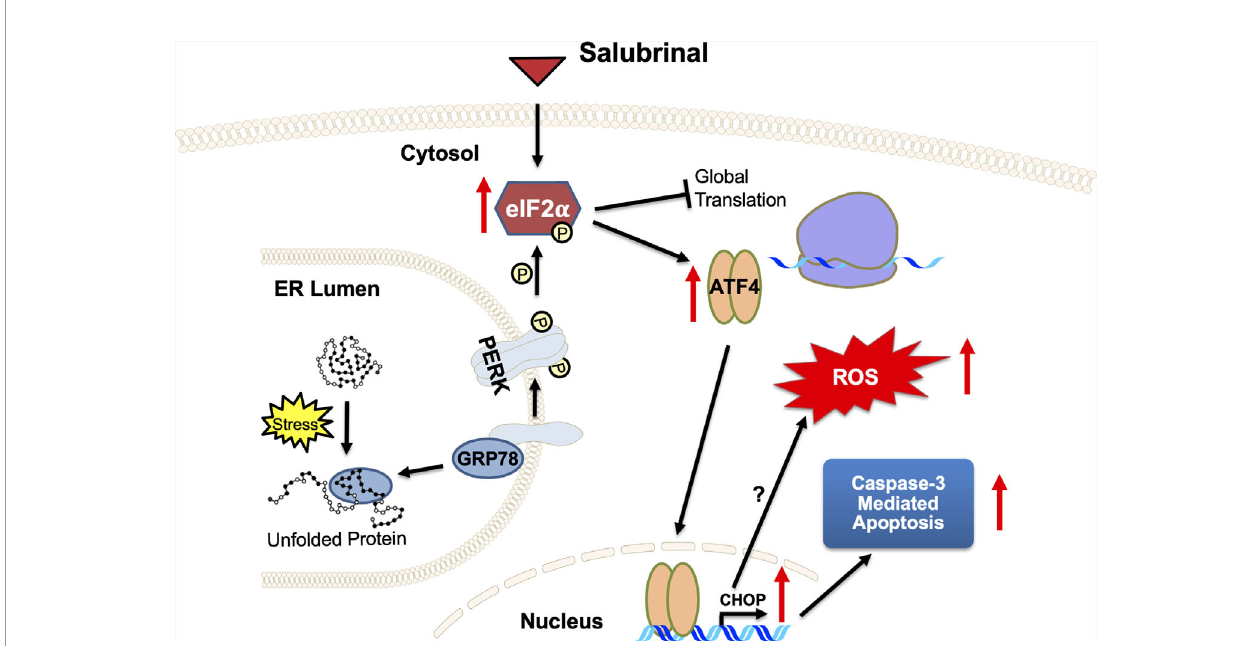
FIGURE 8 | A proposed mechanism of action of ER stress ‐ prolonging agent Salubrinal on IBC cells. Cellular stress causes unfolded proteins to accumulate in the ER lumen. Chaperone dissociation leads to the activation of the PERK arm of the UPR. PERK is a transmembrane protein that serves as an ER stress sensor and activator of the UPR. PERK phosphorylates eIF2 a , thereby inhibiting global translation and selectively promoting ATF4 and CHOP translation, stress-inducible transcription factors. Salubrinal, an eIF2 a phosphatase inhibitor, activates the PERK arm of the UPR. Upregulation of CHOP, a proapoptotic transcription factor downstream of PERK and ATF4, demonstrates a potential antitumor strategy of Salubrinal in IBC cells. Salubrinal-treated IBC cells are driven to caspase-3 mediated cell death. Salubrinal treatment-induced cellular ROS and downregulated IBC cell proliferation, which could be rescued upon treatment with antioxidant along with Salubrinal. There may be CHOP-mediated induction of ROS or ROS is the outcome of upregulated oxidoreductases and protein oxidation in the IBC